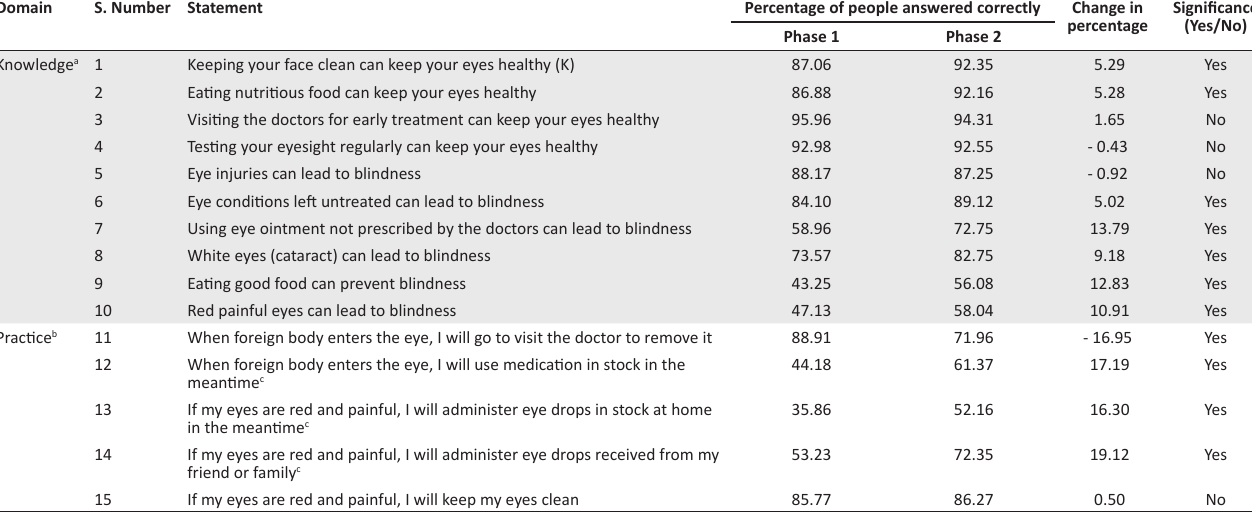
TABLE 2: Change in knowledge, attitude and practice before and after intervention. Domain S. Number Statement Percentage of people answered correctly Knowledge a